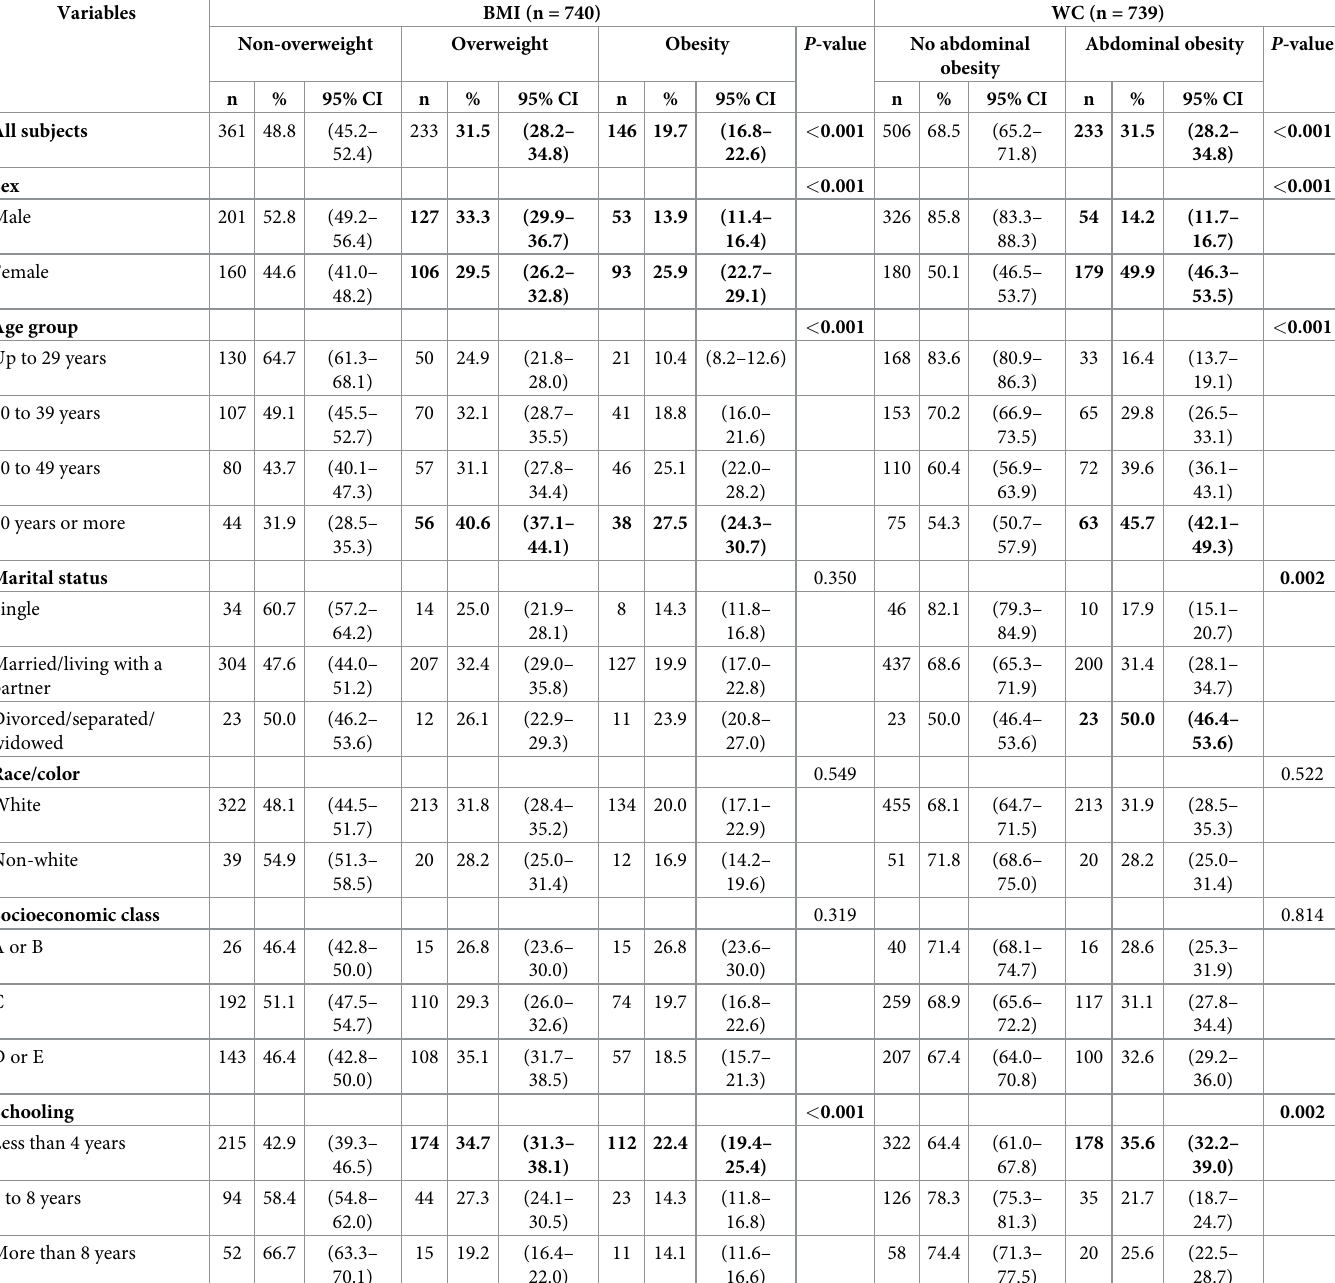
Table 2. Nutritional status and prevalence of general and abdominal obesity in a rural Brazilian area, according to sex, age group, marital status, race/color, socio- economic class and schooling.